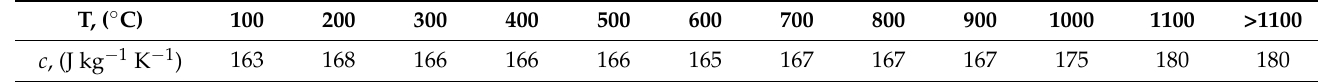
Table 3. The specific heat used in the